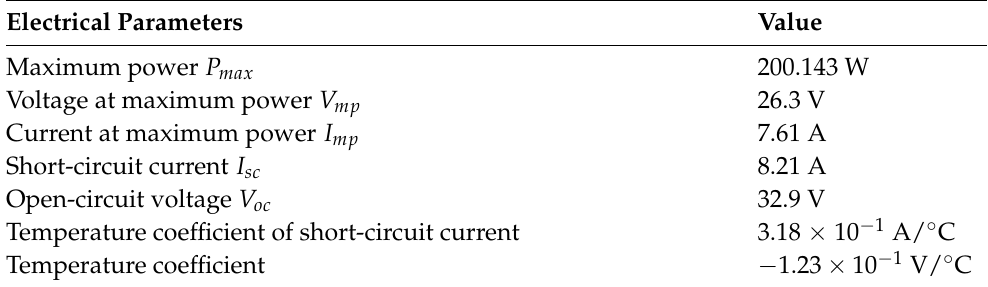
Figure 3. Block diagram of the digital controller for the MPPT of the boost converter. Table 2. Electrical characteristics of the PV module